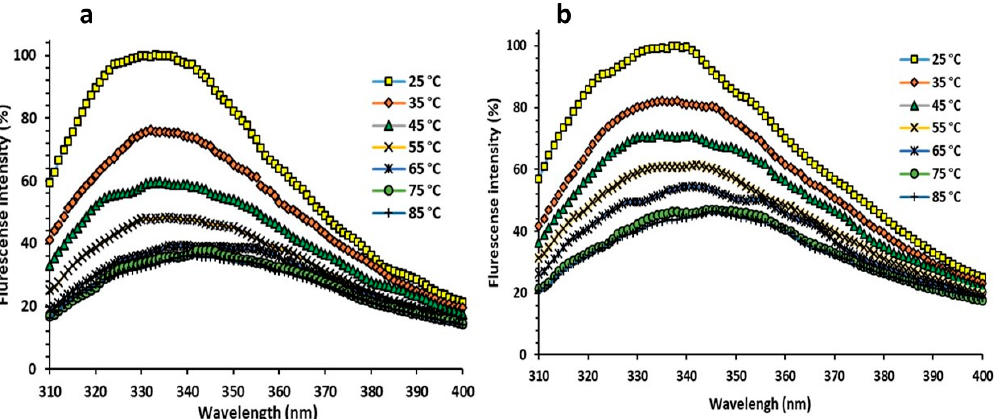
Figure 10. Storage stability analysis.